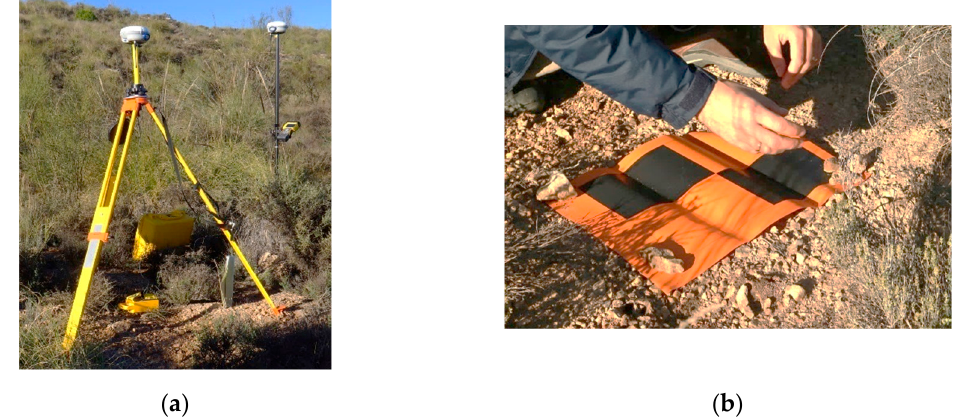
Figure 5. Surveying campaign: ( a ) Trimble R6 Rover and base GNSS receivers; ( b ) target for the ground control points (GCPs).